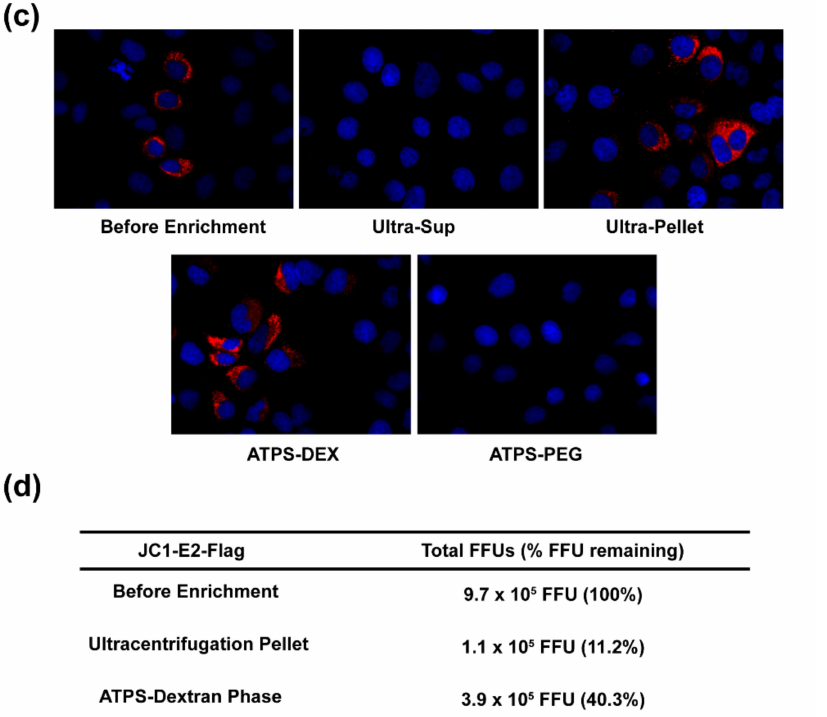
Figure 4. The infectivity of hepatitis C virus (HCV) particles enriched by ultracentrifugation and the aqueous two-phase system (ATPS). ( a ) The Huh-7.5.1 cells were inoculated with the virus (JFH-5a Rluc variant) solutions, and the proliferation levels of HCV were monitored by measuring luciferase activities in the cell extracts. Experiments were performed three times in duplicate. The columns and bars represent the means and standard deviations, respectively. The average value is depicted on the top of each column. p values less than 0.01 are indicated by two asterisks (**). ( b ) Mon- itoring of HCV (JFH-5a Rluc variant) proliferation by western blotting. The levels of the HCV NS5A in the infected cells were monitored by western blotting to observe HCV protein production. ( c ) Immunocytochemistry of HCV (JC1-E2-Flag variant)-infected cells. The HCV core proteins (shown in red) were observed in HCV-infected cells with JC1-E2-Flag. The nuclei of cells (shown in blue) were visualized using 2 (cid:48) -[4-ethoxyphenyl]-5-[4-methyl-1-piperazinyl]-2,5 (cid:48) -bi-1H-benzimidazole tri- hydrochloride trihydrate. ( d ) The focus forming units (FFUs) measured by immunocytochemistry (panel c) are depicted in the chart. The recovery rates were calculated as described in Materials and Methods. ATPS-DEX: ATPS dextran layer; ATPS-PEG: ATPS polyethylene glycol (PEG)